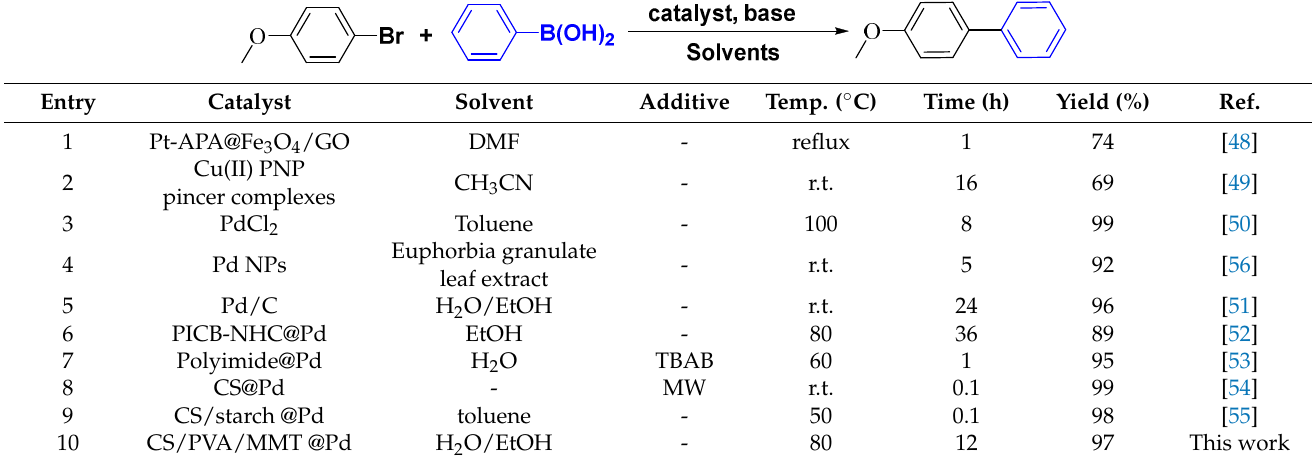
Table 5. Comparison of catalytic performance of CS/PVA/MMT@Pd catalysts with other catalyst materials.